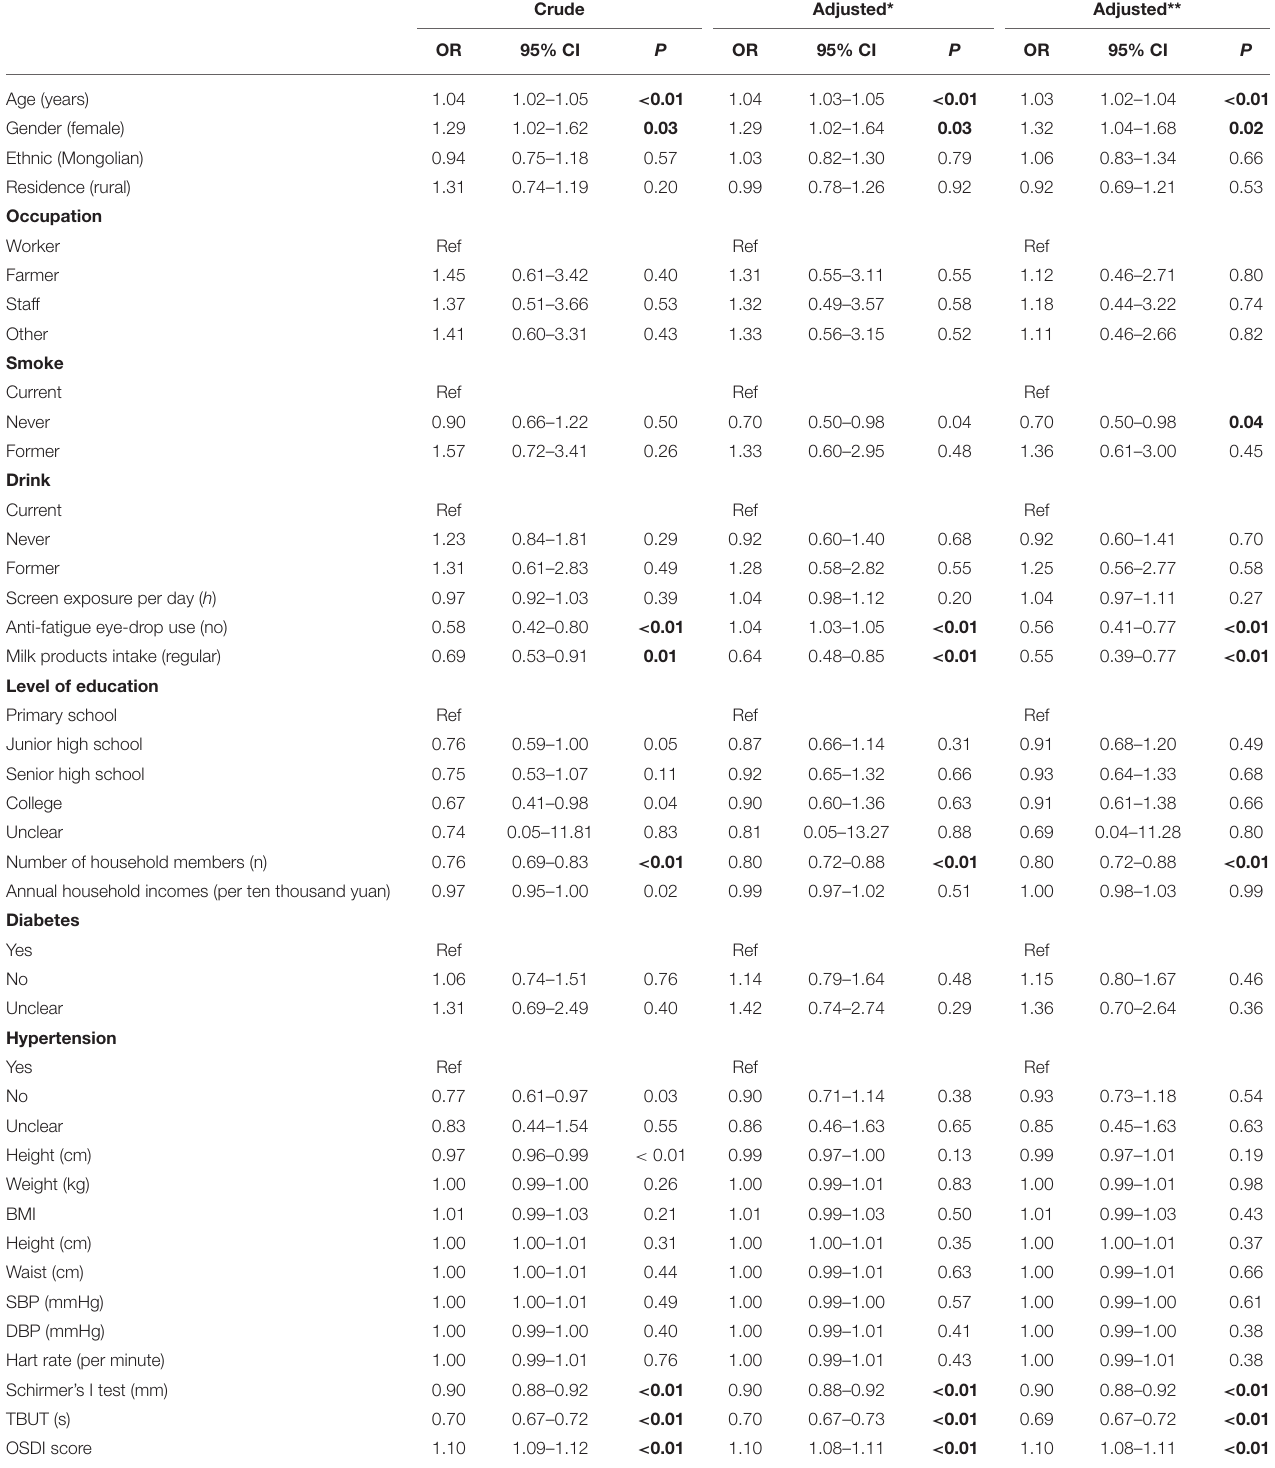
TABLE 2 | Logistic regression analysis of risk factors associated with definite